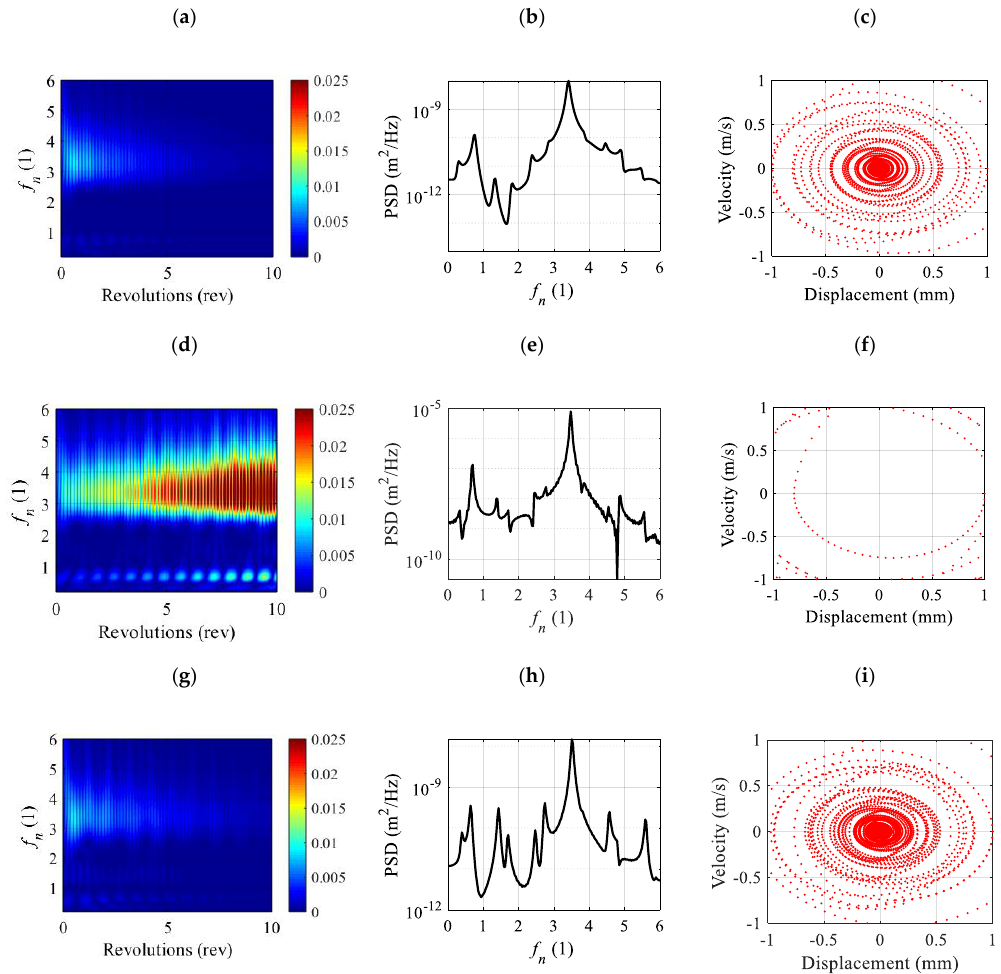
Figure 7. Analysis of cutting conditions A, B and C. Continuous wavelet transform (CWT) scalograms: ( a , d , g ); power spectral density (PSD): ( b , e , h ) and Poincaré maps (PM): ( c , f , i ) corresponds to the cutting conditions A, B and C respectively.